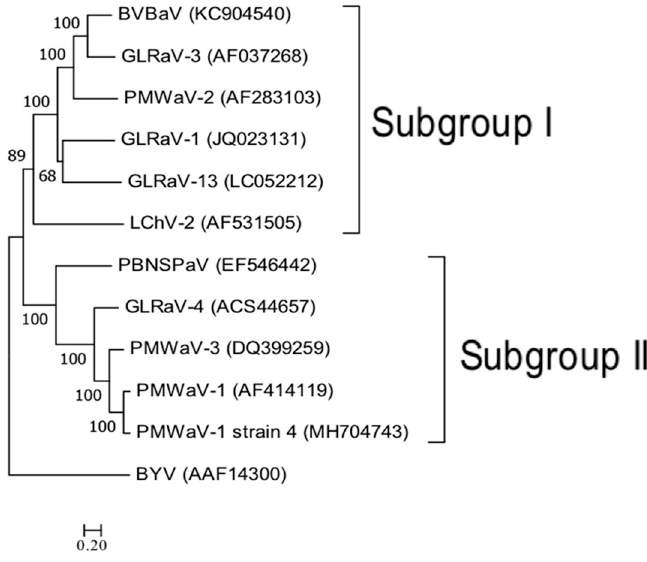
Figure 6. Phylogenetic analysis of ampeloviruses.